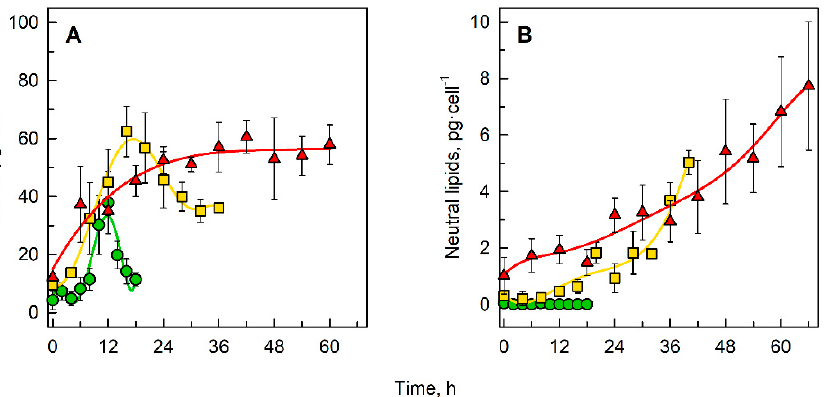
Figure 3. Changes in starch content per cell ( A ) and neutral lipid content per cell ( B ) in synchronous cultures of C. reinhardtii grown in 0% D 2 O (green circles), 70% D 2 O (yellow squares) or 90% D 2 O (red triangles).